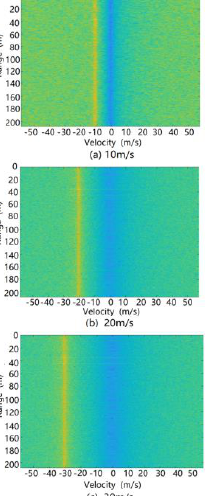
Figure 18. RD spectrum of ground clutter treated by moving target detection (MTD) processing during simulation.